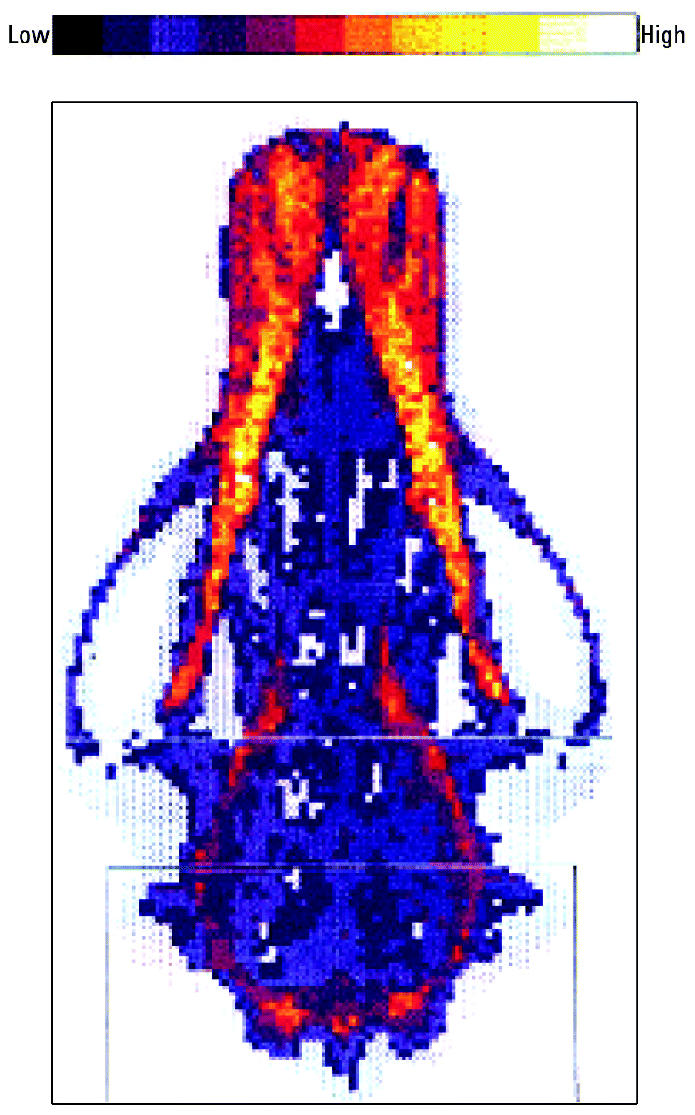
DXA scanning image of a 12-year-old female East Greenland polar bear skull sampled in 1972. Note the high-density areas of cortical bone tissue and the lower density areas of trabecular bone tissue.